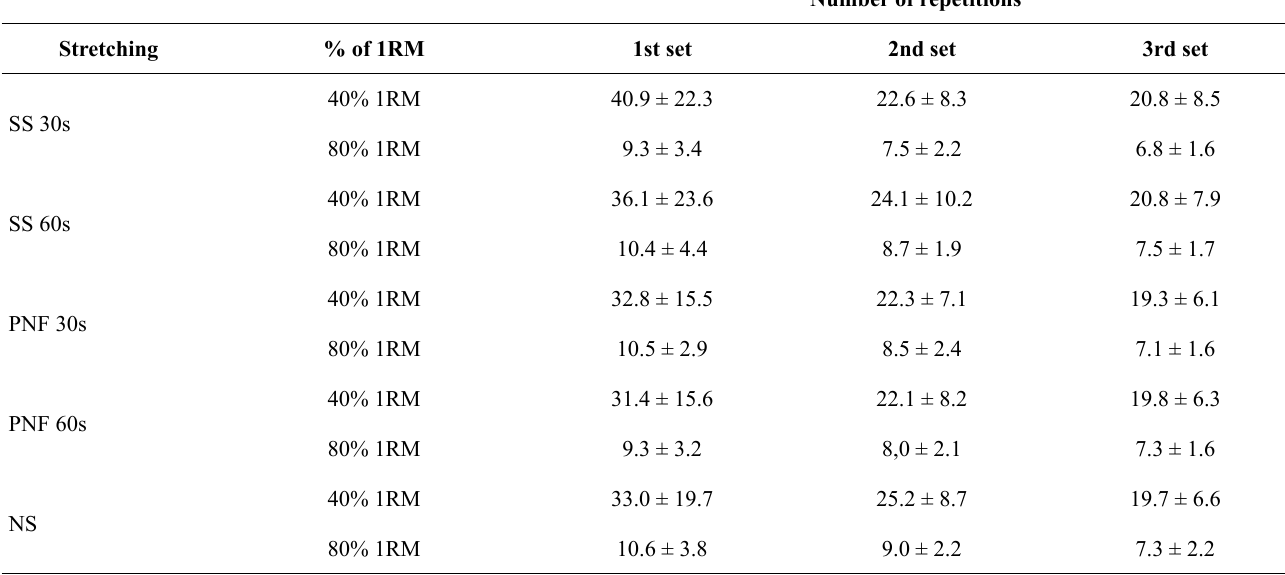
Table 1. Number of repetitions for each set.